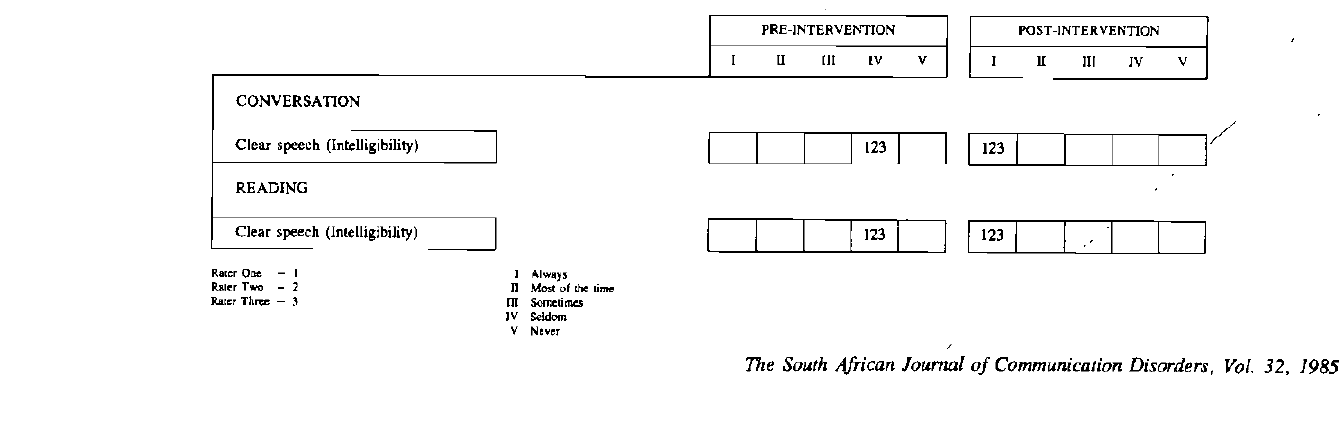
Table 5(i) Analysis of Changes in Laymen's Judgements of Intelligibility of the Speech Sample from the Pre- to the Post- Therapeutic Recording